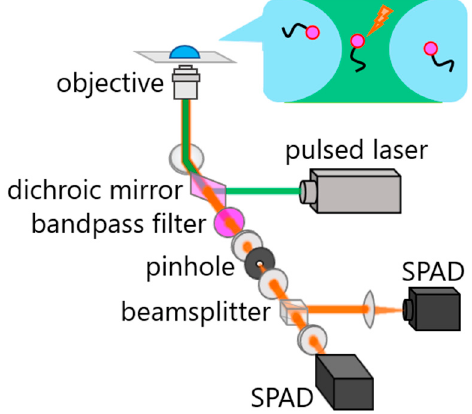
Figure 1. Schematic of a typical 2D FLCS instrument.